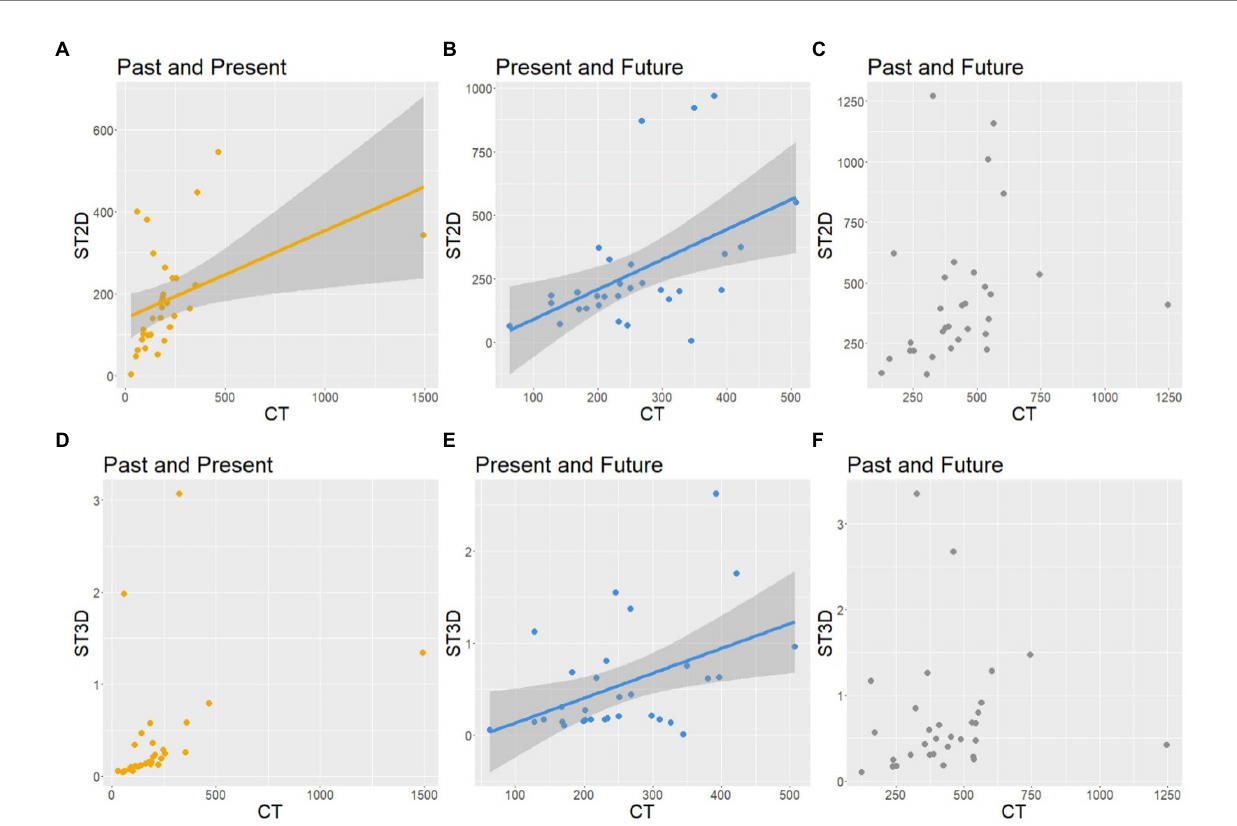
FIGURE 8 Distance between the past and present time zones in ST as a function of the distance in CT. Each dot expresses the past, present, and future positions of a participant. The gray areas surrounding the regression lines indicate the confidence interval. (A) Past-Present distance on the screen in ST. (B) Present-Future distance on the screen in ST. (C) Past-Future distance on the screen in ST. (D) Past-Present distance in 3D space in ST. (E) Present- Future distance in 3D space in ST. (F) Past-Future distance in 3D space in ST.